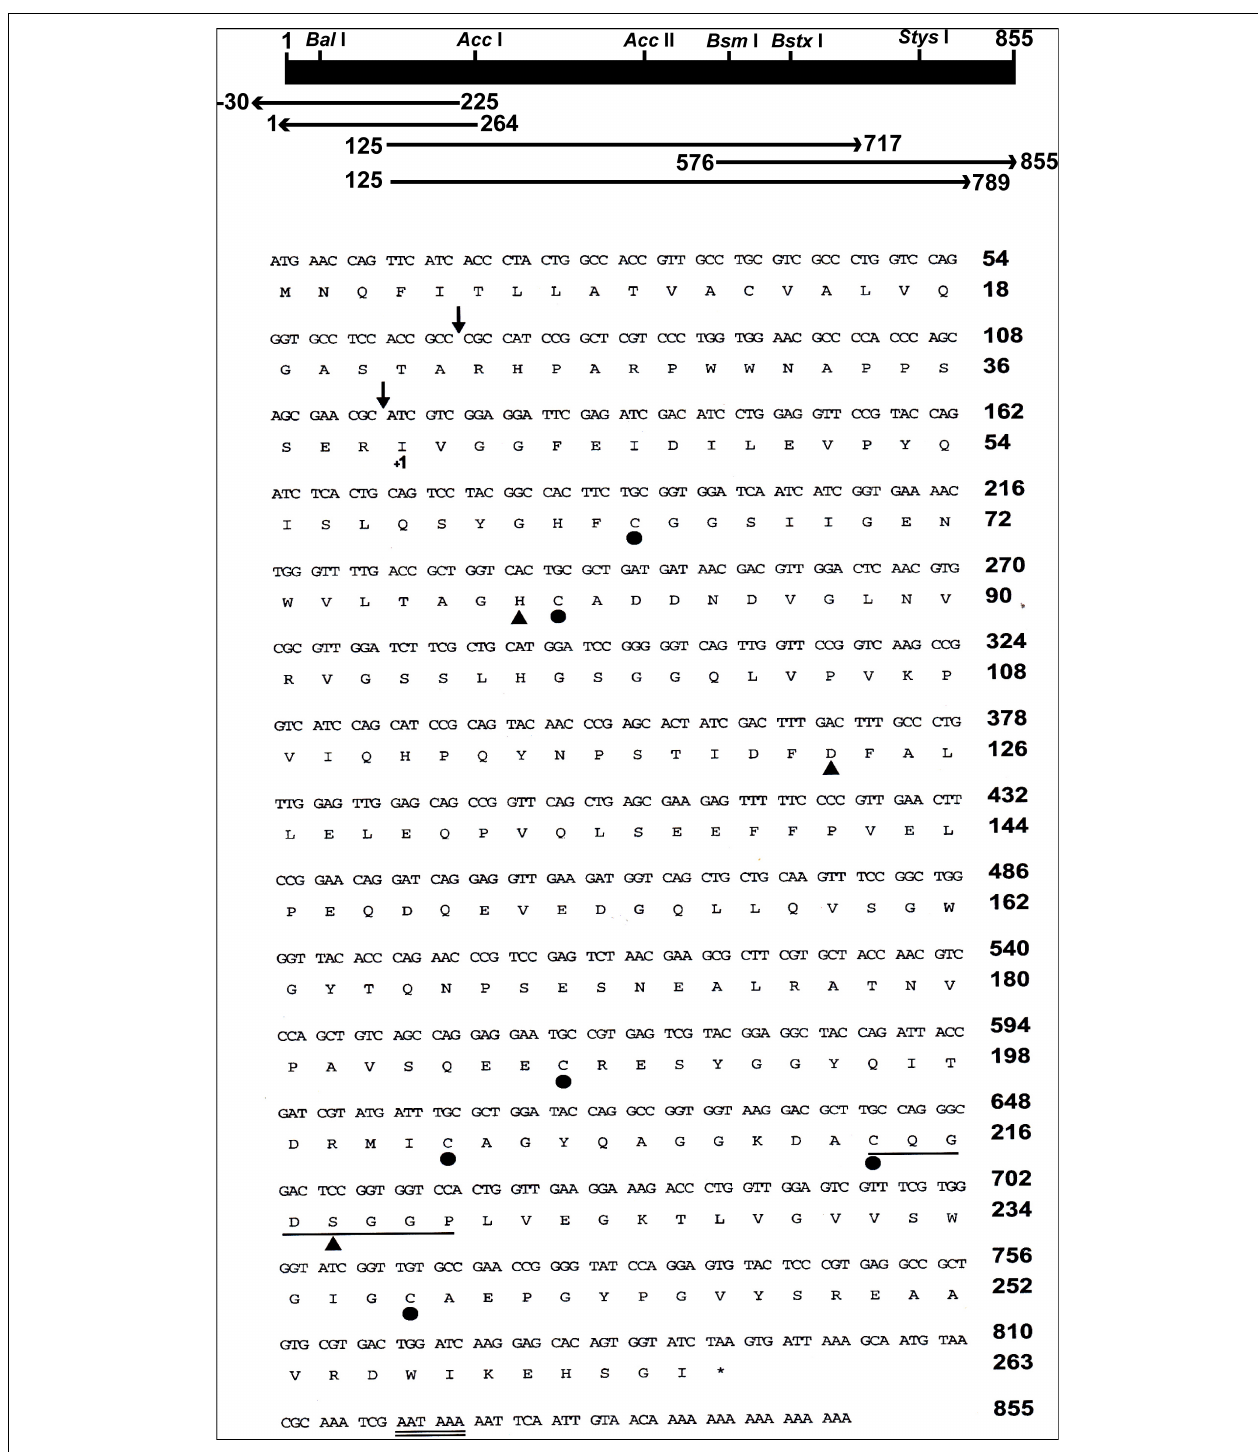
FIGURE 4 | Partial restriction map, cloning and sequencing strategy, and nucleotides sequence, and predicted amino acid sequence of C. quinquefasciatus late trypsin. The horizontal bar (top) indicates the restriction enzymes position of the 855 bp late trypsin. Horizontal arrows show the PCR fragments that were amplified, cloned, and sequenced. Predicted sites of cleavage of the signal peptide and activation peptide are denoted by arrows. The conserved sequence around S218 and the polyadenylation signal are underlined by single and double lines, respectively. The position of the catalytic triad residues is denoted by a close triangle and the positions of the six cysteines are marked by close circles. The numbering of the mature enzyme starts at I40 (+1) after the cleavage site of the activation peptide.